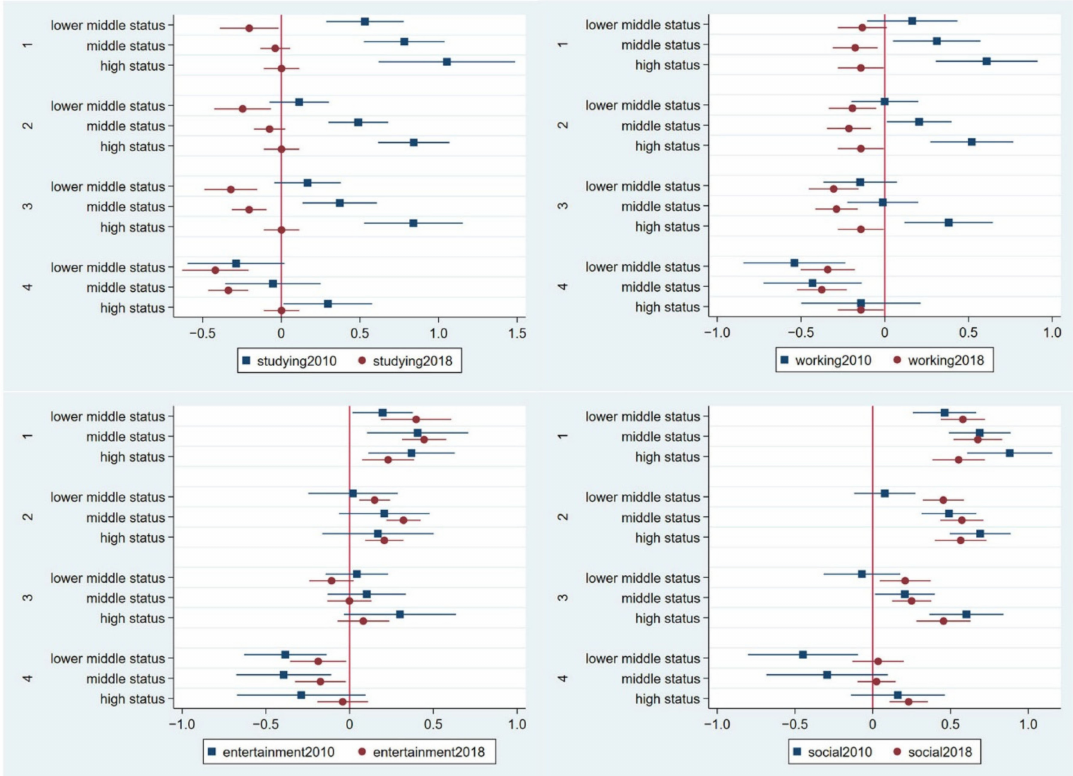
Figure 3. Results of the social status level from the generalised partial proportional odds model predicting the importance of studying, working, entertainment, and social online activities in the 2010 and 2018 panels. Note: The four panels of internet activity evaluation included 1st panel (category 1 versus categories 2, 3, 4, and 5); 2nd panel (categories 1 and 2 versus categories 3, 4, and 5); 3rd panel (categories 1, 2, and 3 versus categories 4 and 5); and 4th panel (categories 1, 2, 3, and 4 versus category 5). The detailed data are provided in Supplemental Material Table